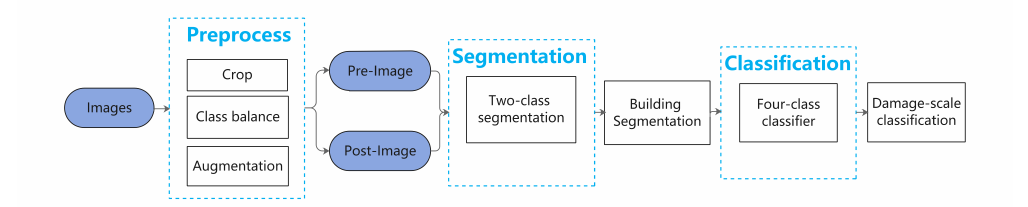
Figure 5. The flowchart of building-level